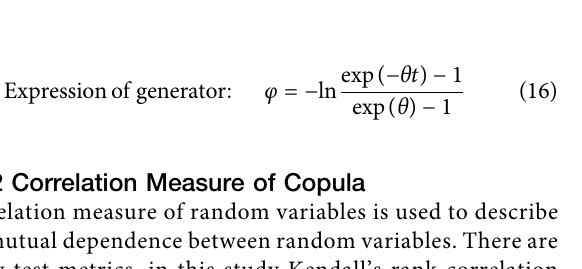
FIGURE 3 | The boxspots of monthly rainfall and runoff in the Xiangxi River watershed. Median id the midlevel line of the data, Upper and Lower are the maximum and minimum values, Q 1 and Q 3 are the lower and upper